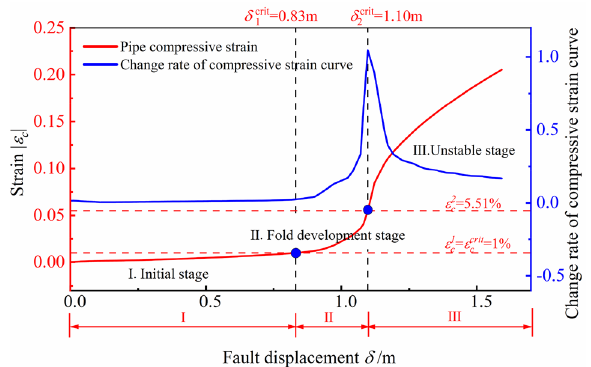
Figure 11. Evolution of the compressive strain under the oblique-reverse fault displacement ( β = 90°, ψ = 60°, h = 1.2 m, t = 22 mm, D = 1.219 m, P = 12 MPa).